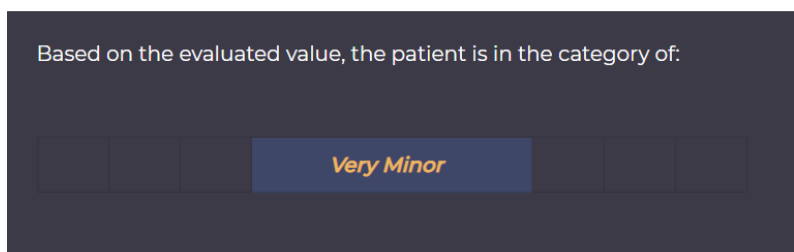
Figure 6. The DSS interface for user